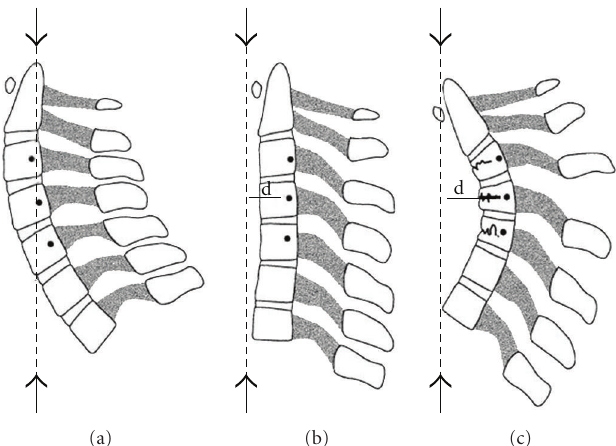
Figure 3: Cervical spine postural changes related to the degenerative process will lead to the spondylotic spine. In the normal lordotic posture of the cervical spine, the axial force is applied along the instantaneous axis of rotation (IAR) with no deviation from this neutral point of rotation (a). However, with early disc height loss, the lordotic posture is reduced and the axial force is now o ff set from the instantaneous axis of rotation (d) causing a moment arm at this point of rotation. If an axial force is placed at a particular distance from the center of rotation or the IAR, a bending moment is applied about this point (b), and it will take less force to induce injury to the apical spinal segment. The larger a moment arm, the greater the bending moment, which will cause further progression of the kyphosis (c). (Taken from Benzel EC: